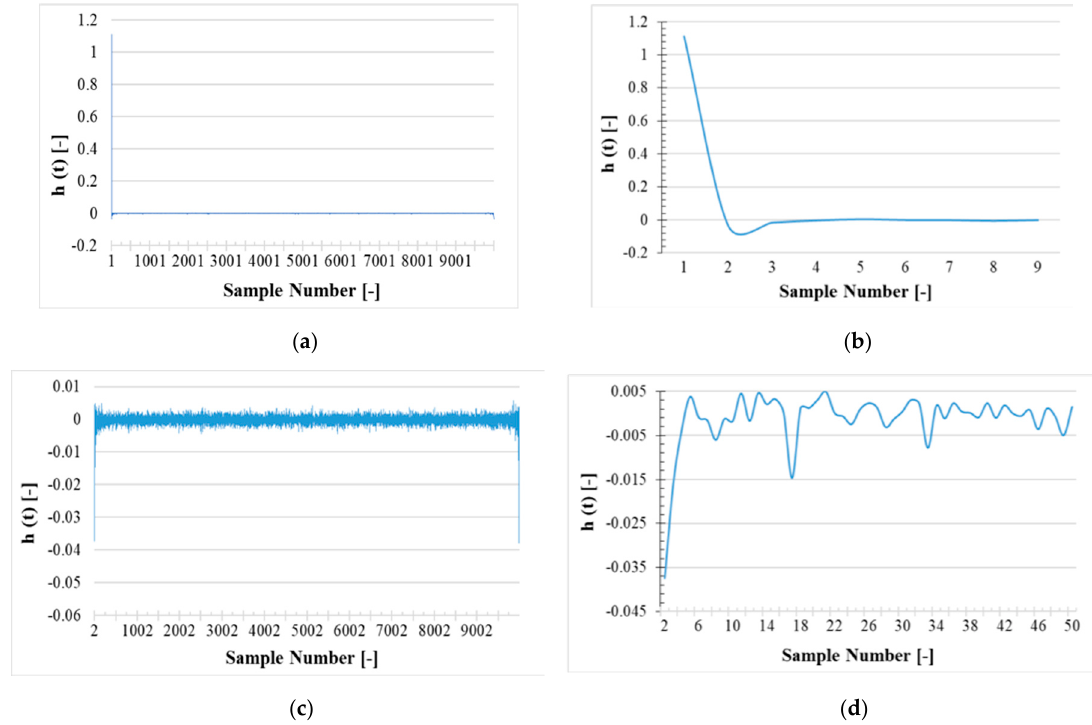
Figure 7. Time domain unfiltered version of The LPVT sampled data transfer function. ( a ) all 10,000